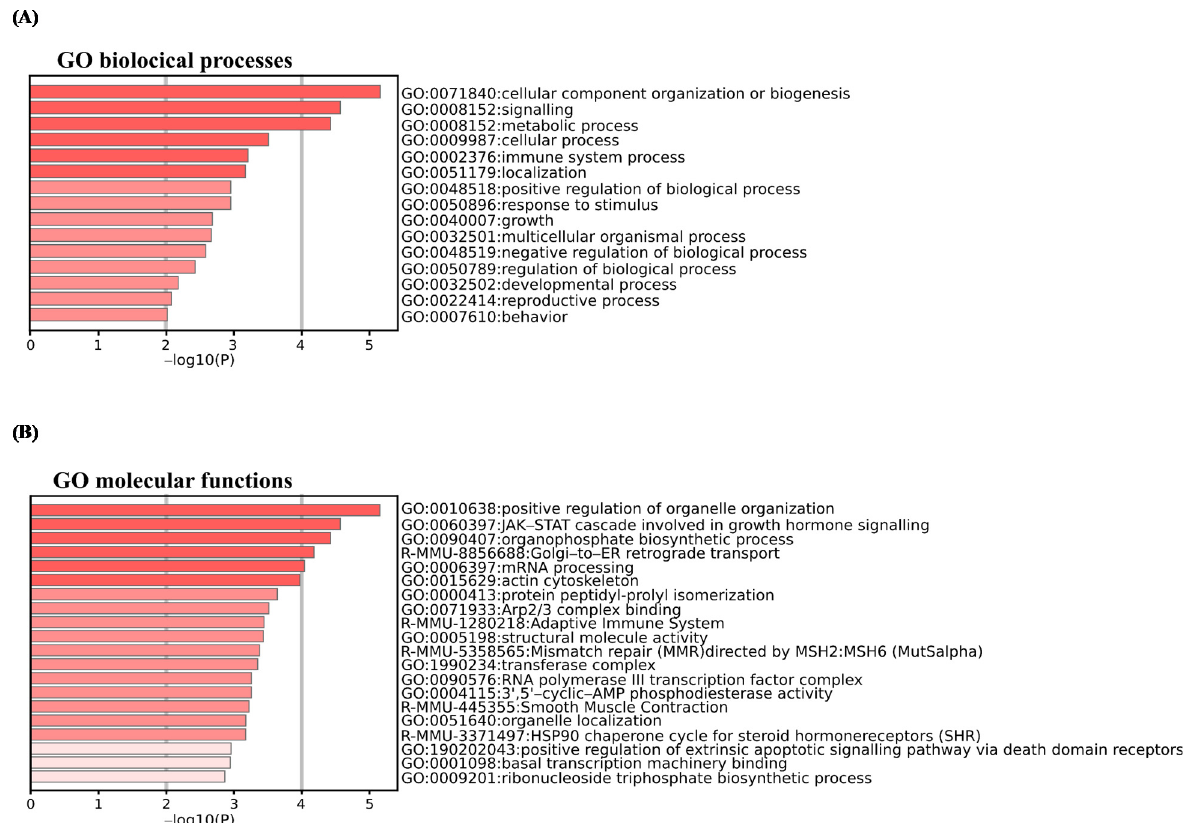
Figure 3. Pathway and process enrichment analysis using Metascape database for DEPs. Enriched pathways and processes were identified using Metascape database (http://metascape.org, (accessed on 7 July 2021)) for all DEPs from ANOVA test and with Kyoto Encyclopedia of Genes and Genomes (KEGG) pathways, Gene Ontology (GO) biological processes, GO cellular component, GO molecular function, Reactome Gene Sets, and CORUM as ontology sources. Top enrichment biological processes ( A ) and molecular functions ( B ) term clusters, colored by − log 10 ( p -value). Threshold: 0.3 kappa score; similarity score > 0.3. The darker the color is, the more significant the term. Significant terms were then hierarchically clustered into a tree based on kappa—statistical similarities among membership similarities. Then, the 0.3 kappa score was applied as the threshold to cast the tree into term clusters. More specifically, the most statistically significant term within a cluster was selected for cluster annotation. The first 20 significant most representative term clusters are shown.